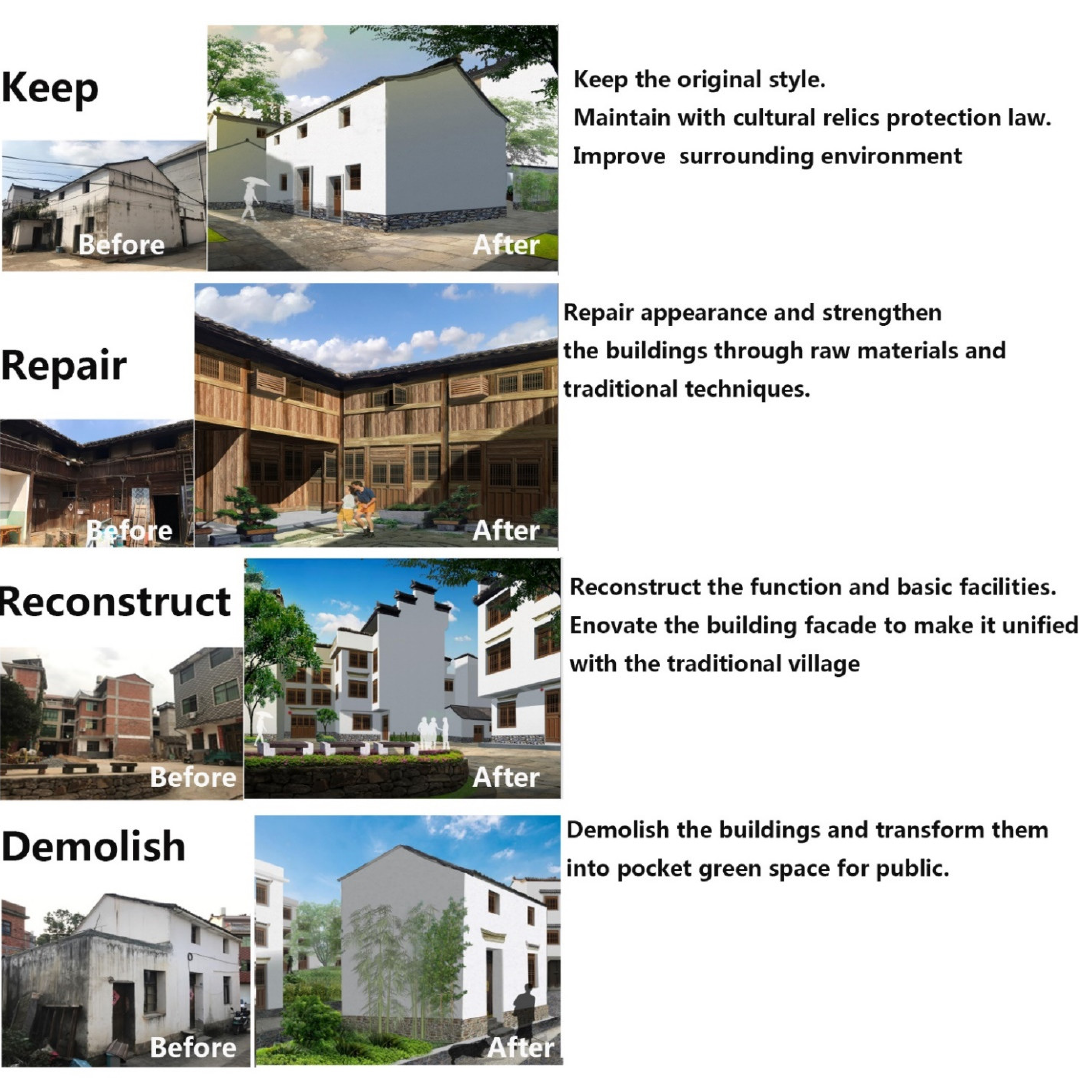
Figure A1. Scenarios to describe four micro-regeneration intervention types.